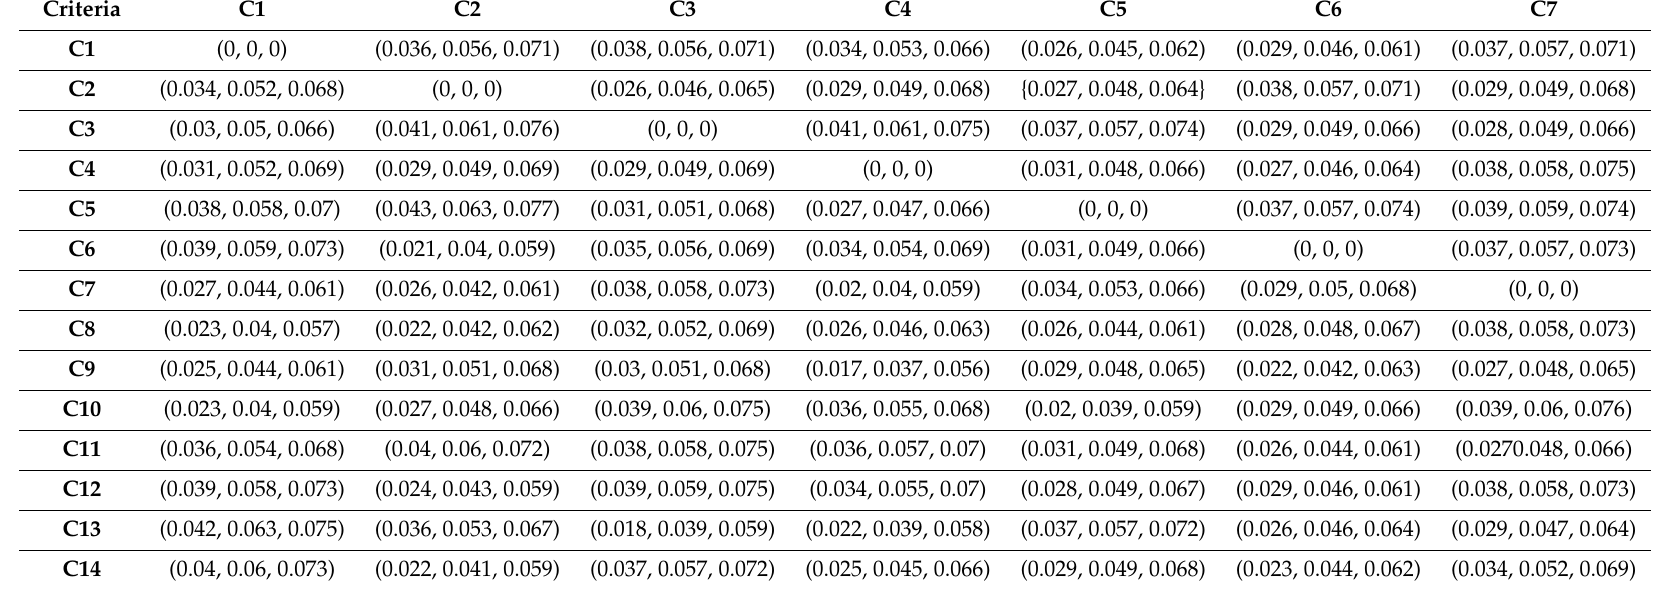
Table 2. The initial direct-relations fuzzy matrix of expert 1 to 7.